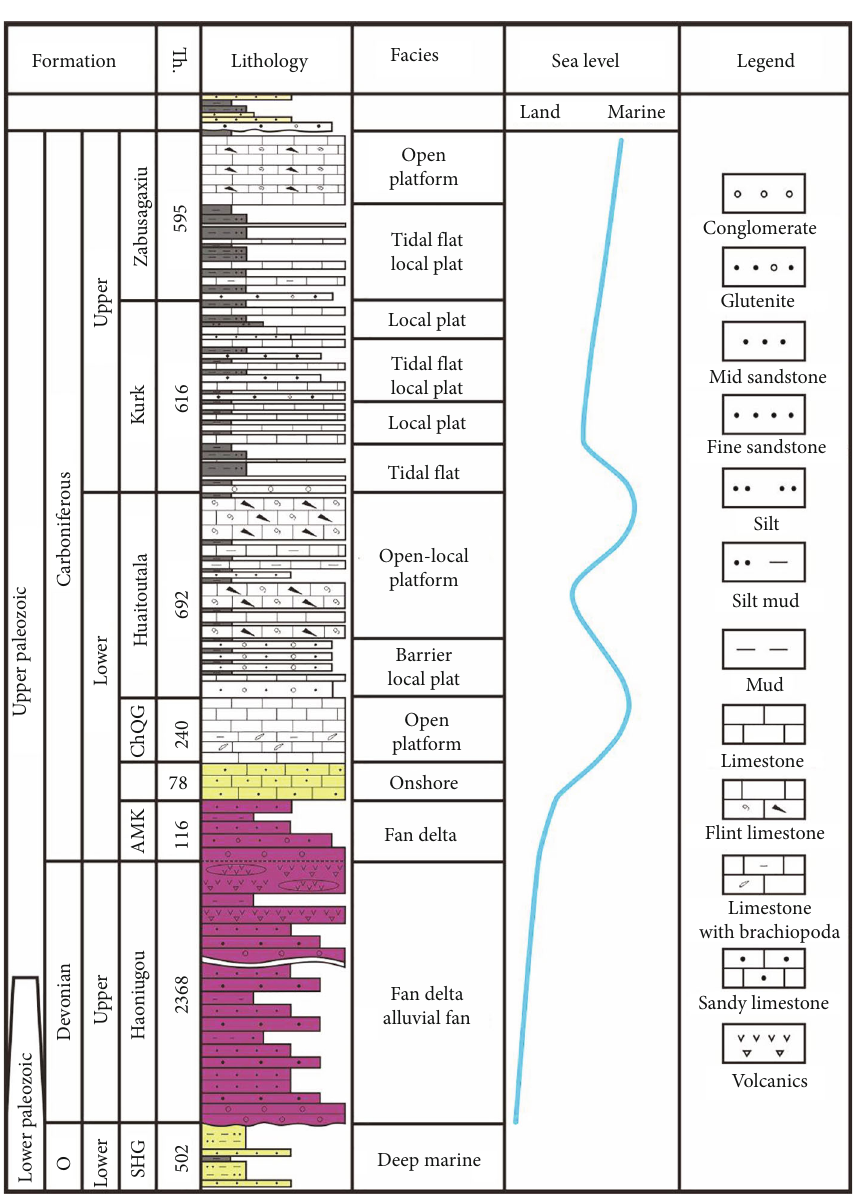
Figure 2: Comprehensive stratigraphic column of study